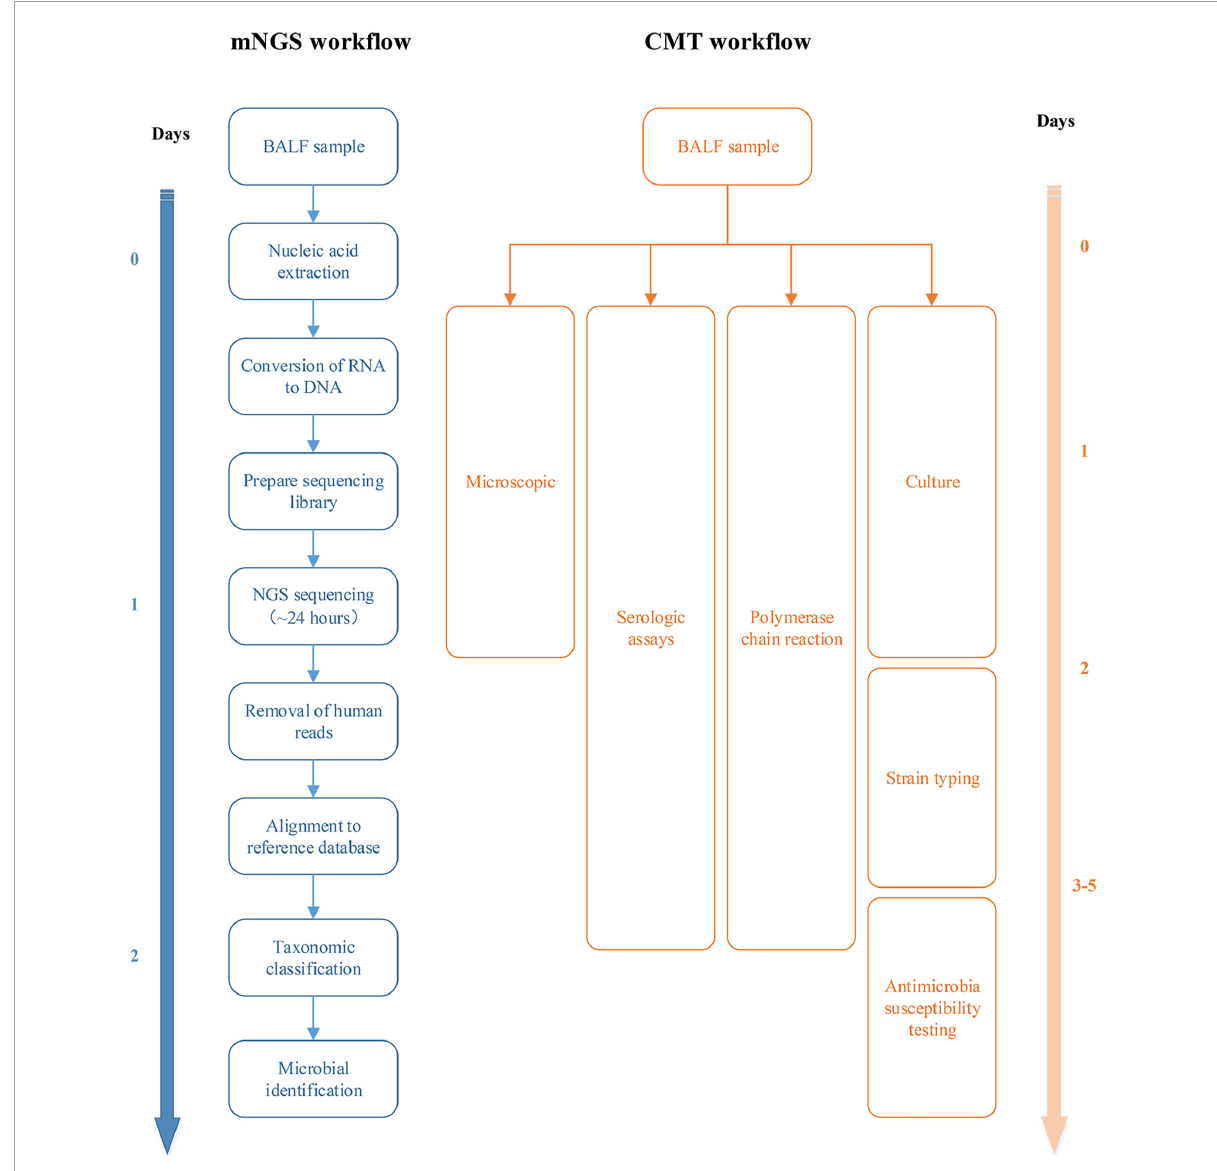
FIGURE1 Workflow and timeline for metagenomic next-generation sequencing (mNGS) and conventional microbiological test (CMT).